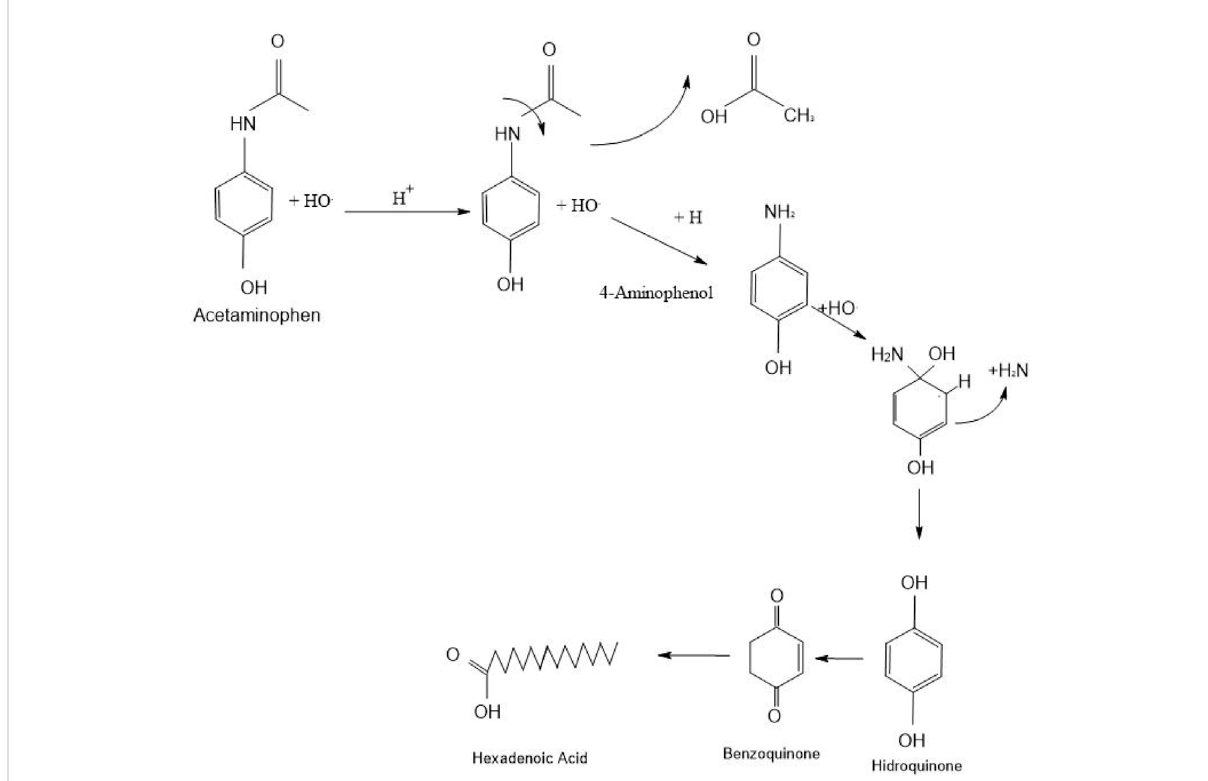
FIGURE 9 Major organic intermediates identi fi ed in the acetaminophen transformation pathway with TiO 2 -Ag catalysts synthesized by the sol – gel method, where the predominant phase is anatase. Under the following reaction conditions: reaction volume: 250 ml, catalyst mass = 2 g/l, four commercial visible light lamps were irradiated.